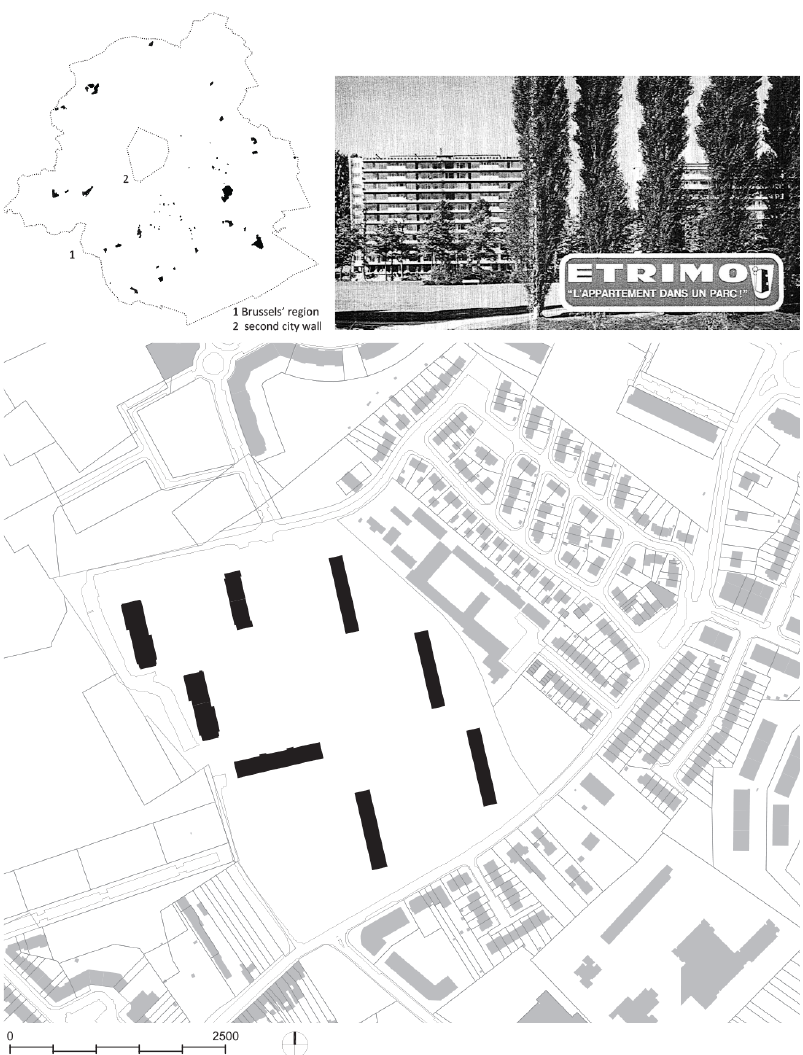
Figure 9. Etrimo’s parcels in Brussels; Groupe Urbanisme, Parc Schuman , 1964 (drawings by the author; advertisement by Etrimo,